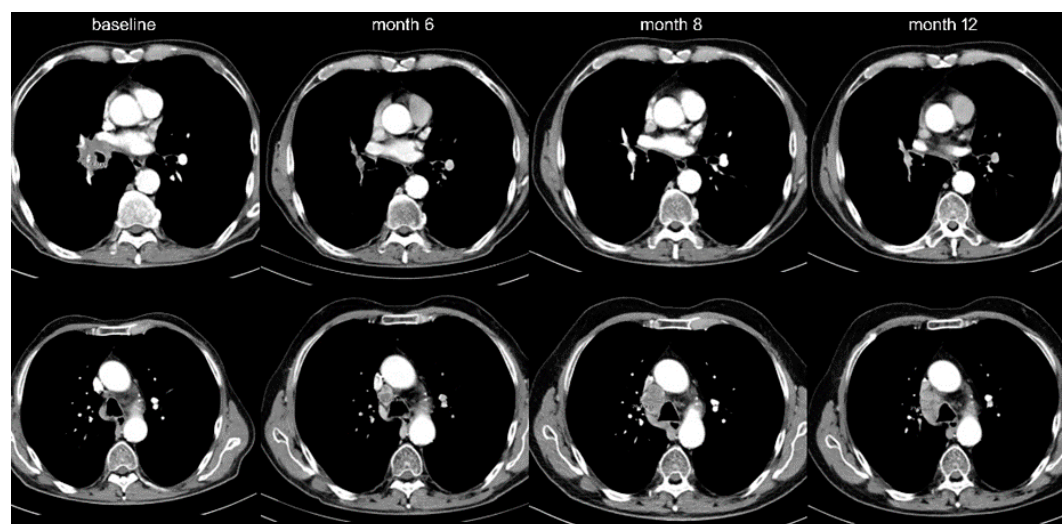
Figure 2. Lymph node oligoprogression. A 66-year-old male patient with adeno-NSCLC (PD-L1 90%) was started on pembrolizumab in November 2017. Nodal progression on the right side was noted in June 2018, which appeared stable in a subsequent restaging in October 2018, even though no change in therapy occurred.